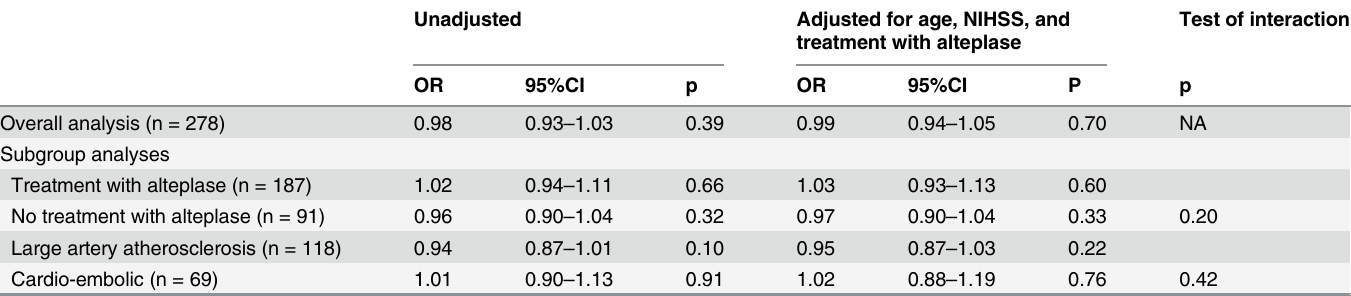
Table 2. Results of unadjusted and adjusted logistic regression on the relation between body temperature and recanalization.